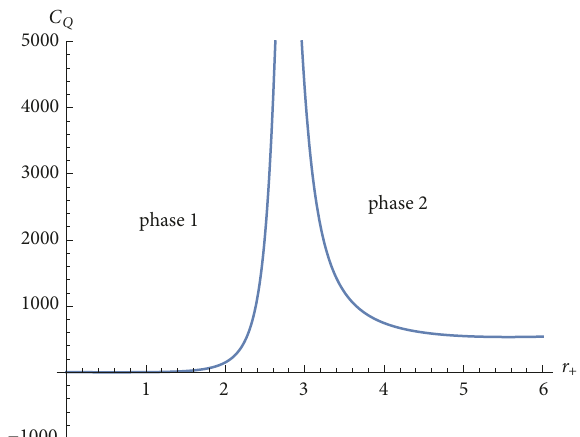
Figure 2: 𝐶 푄 −𝑟 + diagram of charged AdS blackholes in therainbow gravity. It corresponds to 𝑙 = 7.05 . We have set 𝑄 = 1 , 𝜂 = 1 , 𝑚 = 0